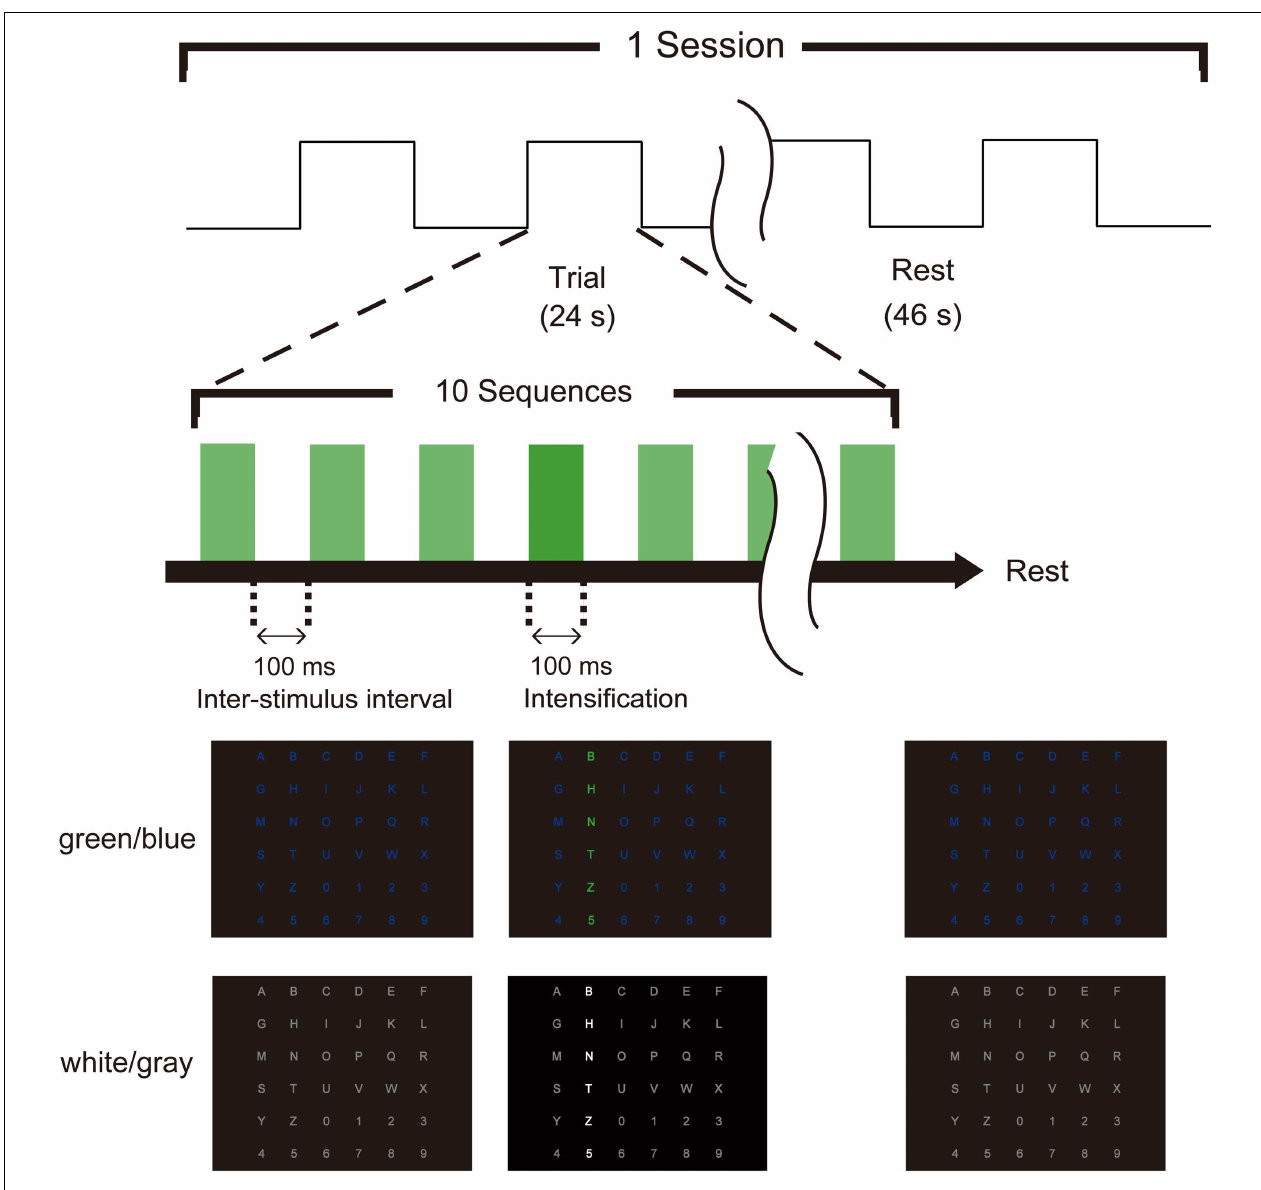
intensification and a 100-ms inter-stimulus interval.Ten sequences constituted a trial, and the subject focused on one target icon during each trial. EEG data were collected with the trigger of intensification, and fMRI data were recorded